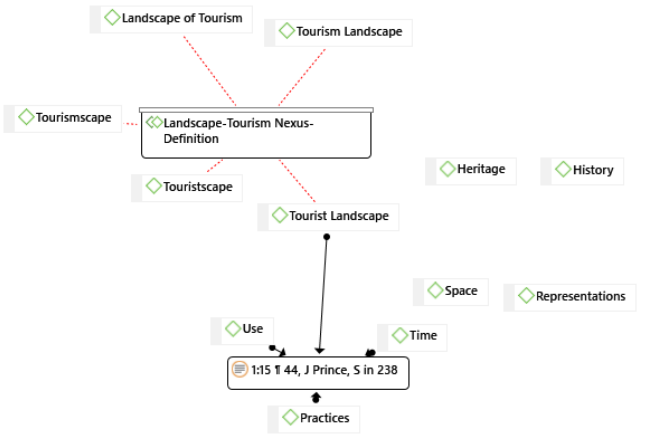
Figure 10. Linkages between publication 2, definitional aspects, and codes by ATLAS.ti. The figure shows a publication where “tourist landscape” is used to investigate themes mostly related to the conceptual code “Practice”.